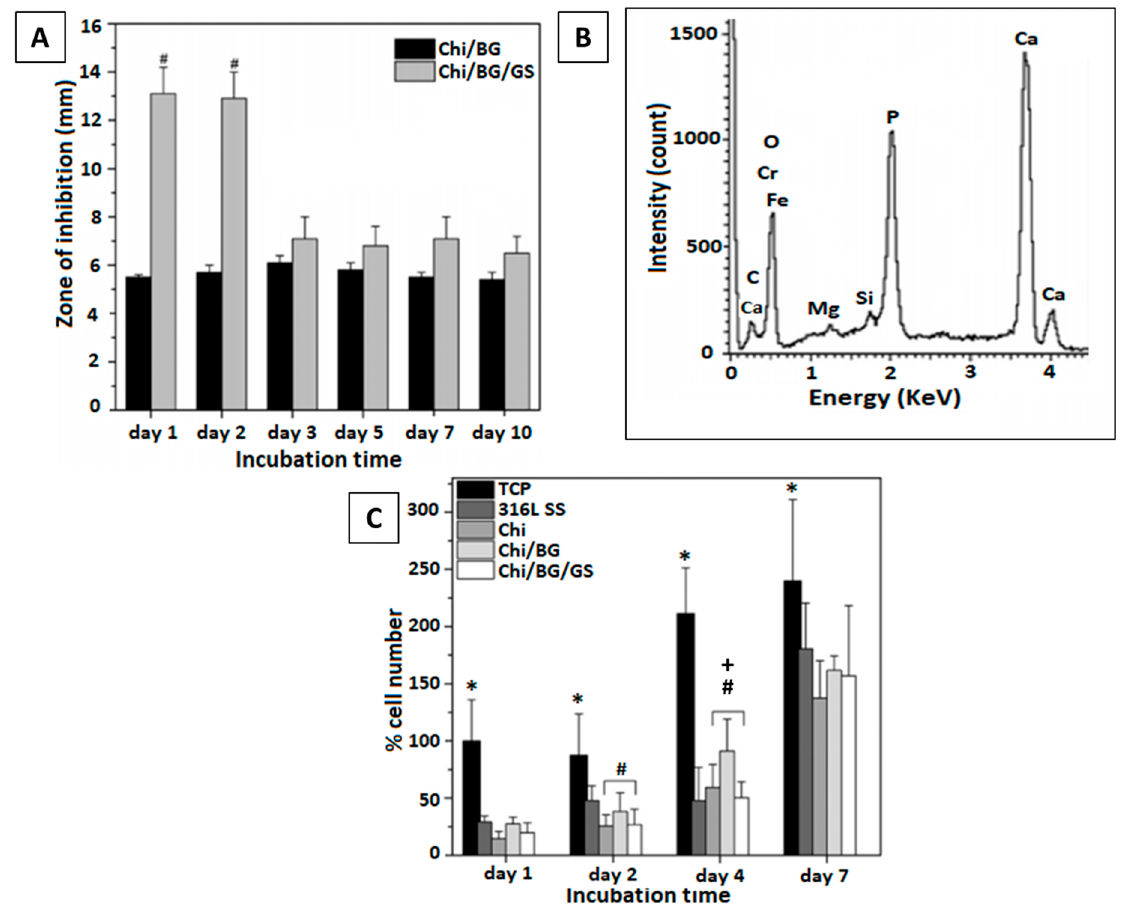
Figure 8. In vitro bioactivity tests performed for chi/BG/gentamicin (GS) composite coating: ( A ) zone of inhibition produced by composite coating immersed in PBS after 10 days, ( B ) EDX spectra confirming the presence of Ca and P, ( C ) cellular response of composite coating (Chi/BG/GS) as compared to tissue culture plate (TCP) (316L-SS substrate, chi), and Chi/BG coating. * is for TCP vs. all other coatings; # is for marked bar vs. 316L SS; + is for marked bar vs. CS/BG. Reproduced from [79] with permission from the American Chemical Society™.